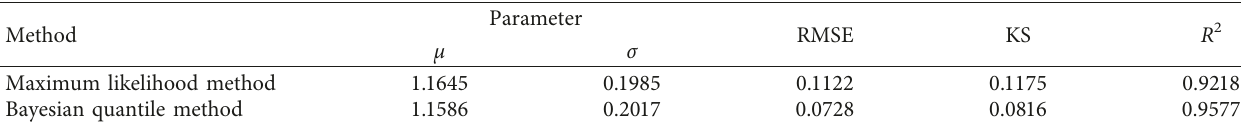
Table 3: Parameter estimates, RMSE, KS, and R 2 for the driven pile